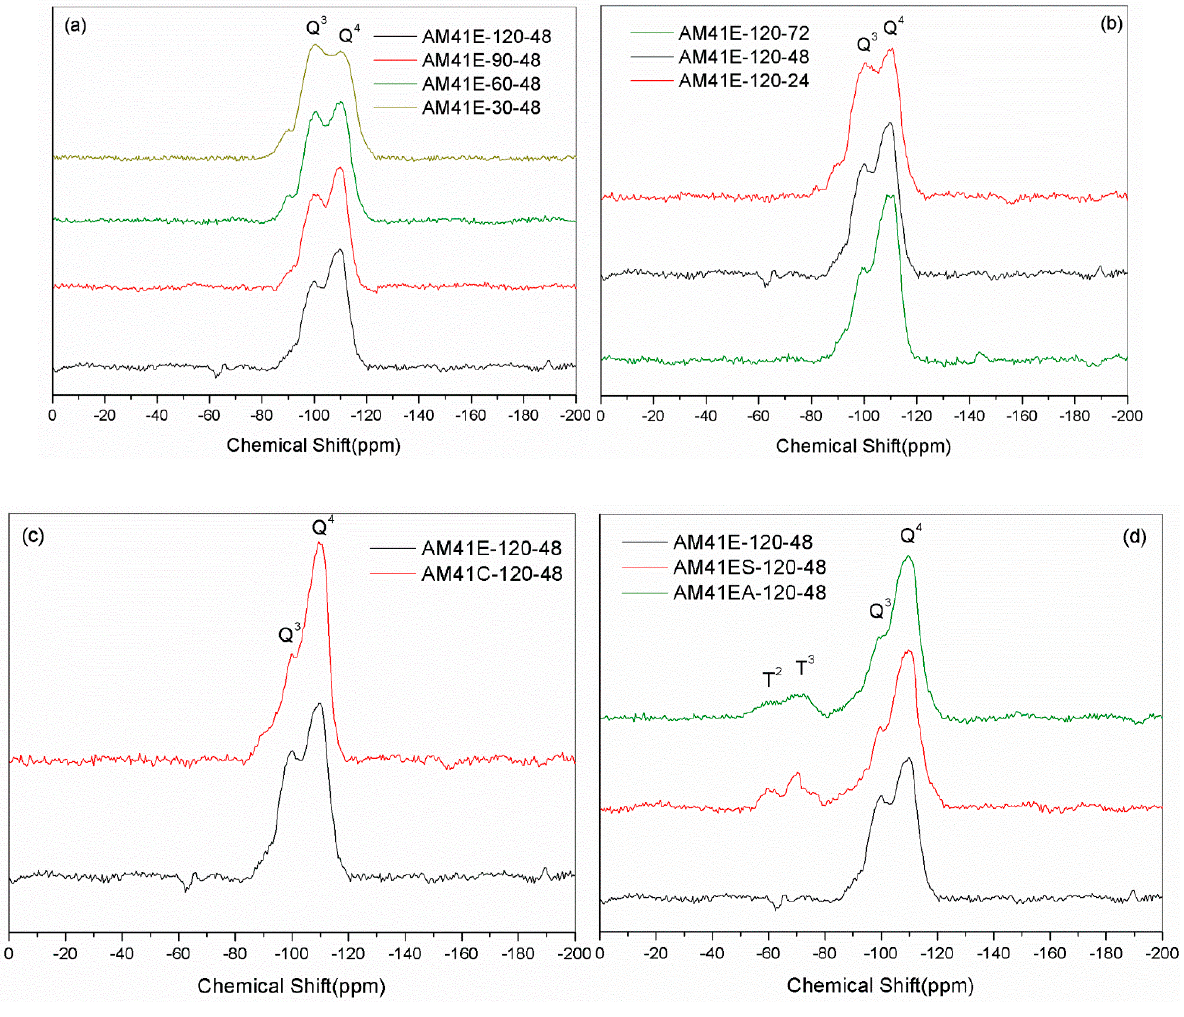
Figure 9. 29 Si MAS NMR spectra for ( a ) AM41E-120-48, AM41E-90-48, AM41E-60-48, and AM41E-30-48, ( b ) AM41E-120-72, AM41E-120-48, and AM41E-120-24, ( c ) AM41E-120-48 and AM41C-120-48, and ( d ) AM41E-120-48, AM41ES-120-48, and AM41EA-120-48. Table 6. Deconvolution analysis of 29 Si NMR results.